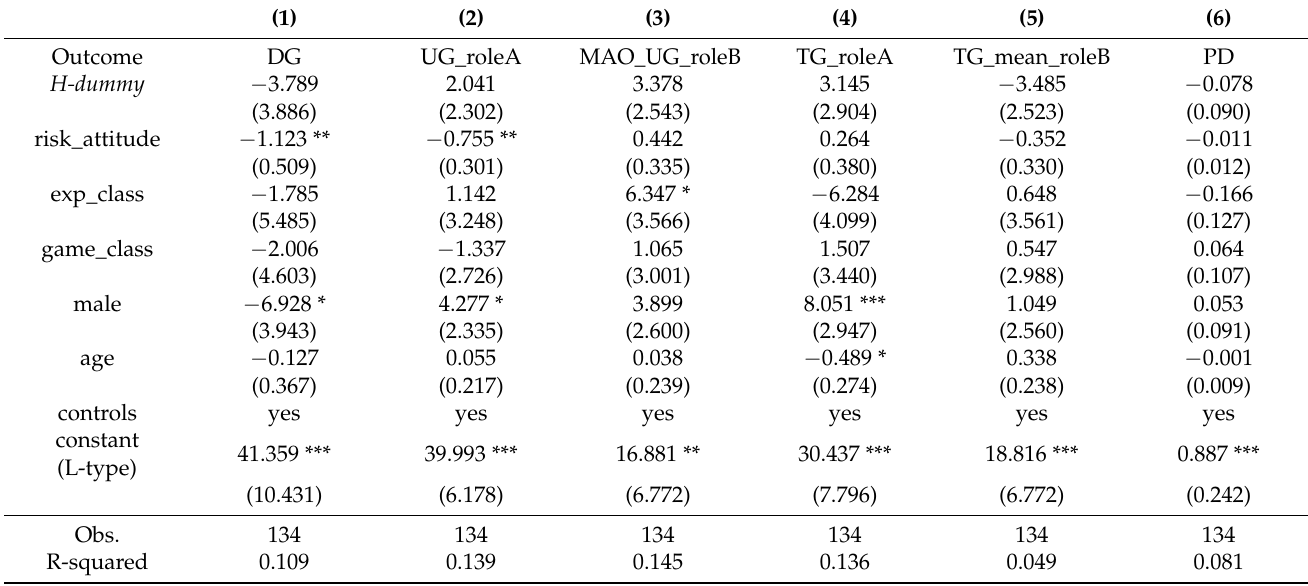
Table 5. Sophistication effect (parametric